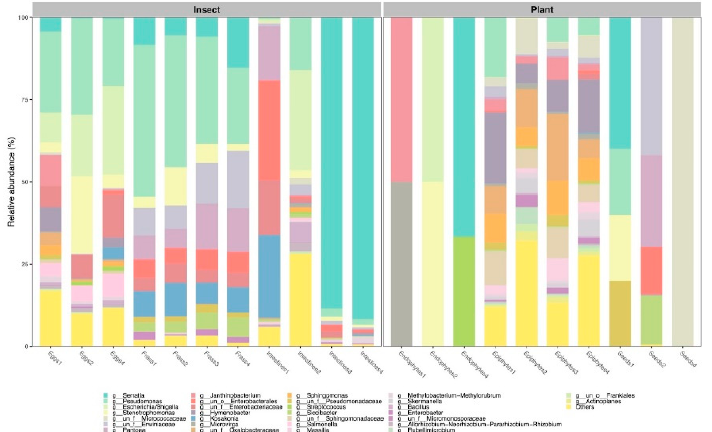
Figure 2. Taxonomic composition of the 12 most abundant bacterial genera of the plant D. inoxia and its specialist insect L. daturaphila. In the insect, it represented 70.2%, while in the plant, it corresponded to 56.3% of the total readings.